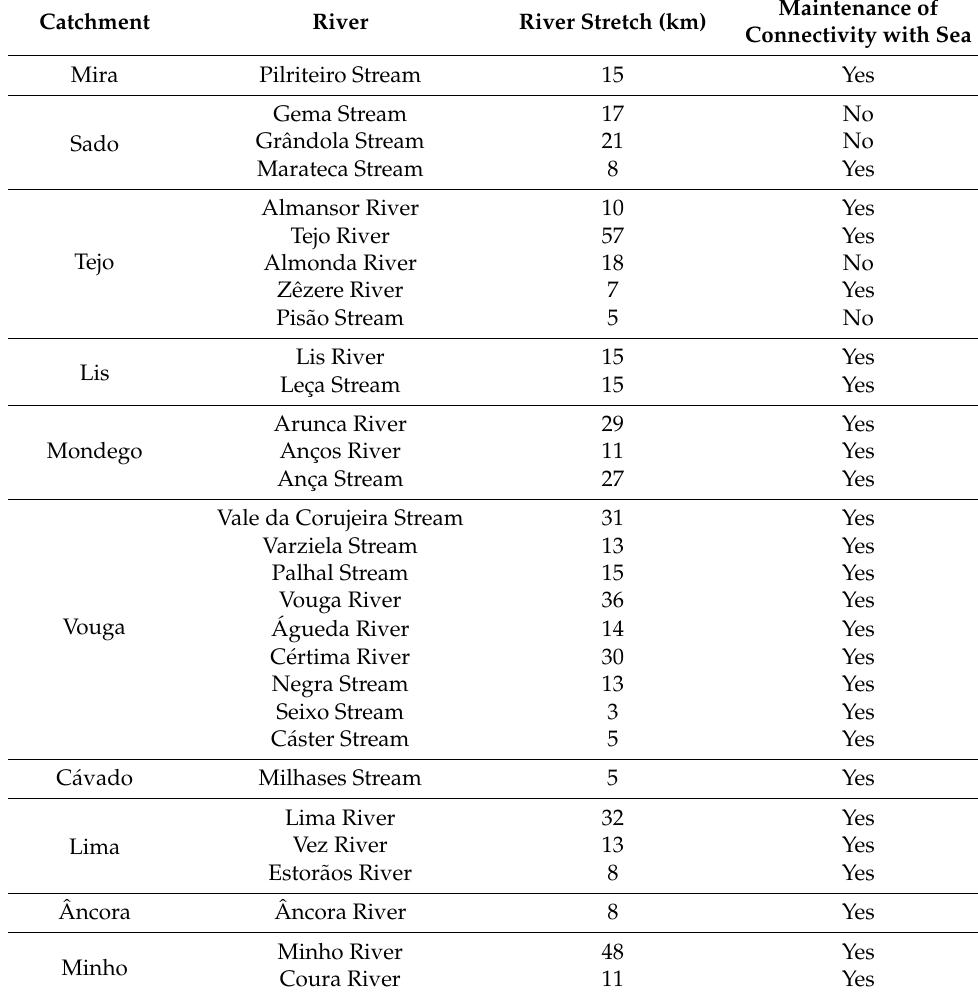
Table 2. Table with rivers categorized with the maximum level of conservation priority, number of kilometers covered, presence/absence of the species and the need for measures directed to the maintenance of connectivity with the